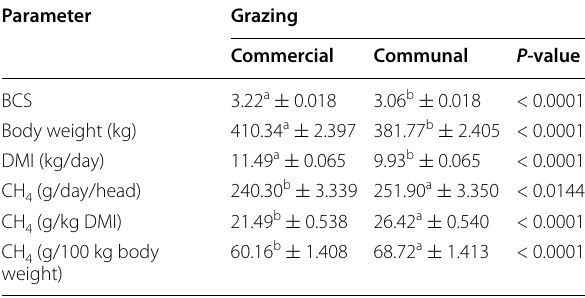
Different letters “a and b” represent significant differences (P grazing systems